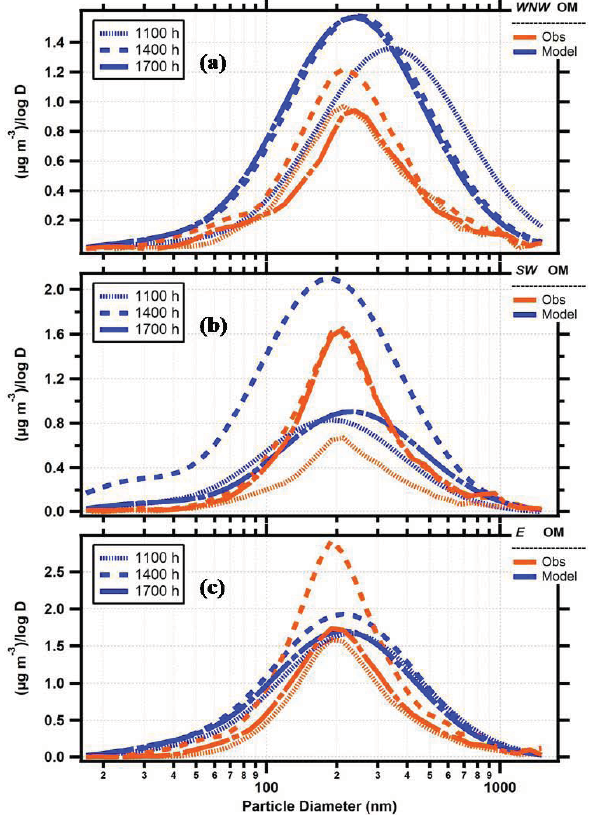
Figure 9. The size distributions are for the same conditions described in Fig. 6, but for organic material. Fig. 9. The size distributions are for the same conditions described in Fig. 5, but for organic